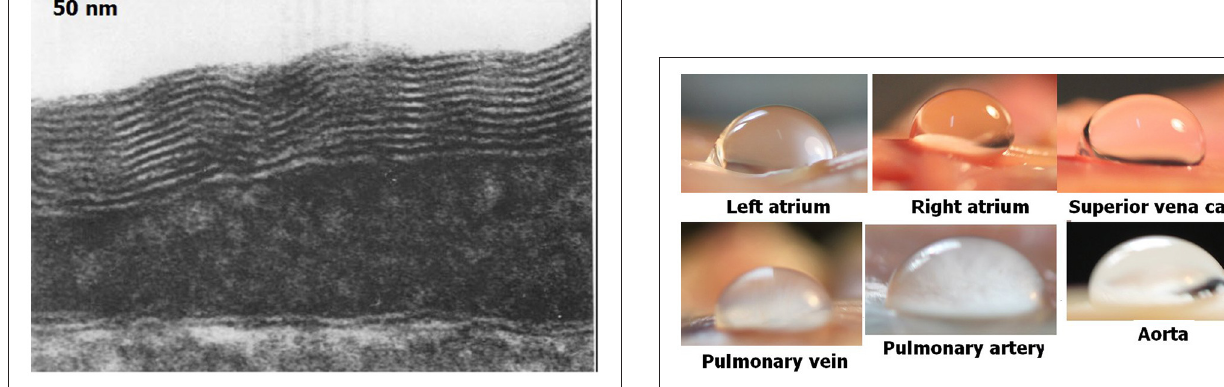
FIGURE 4 | Hydrophobicity on blood vessels. Hydrophobicity was demonstrated at specific locations using a small drop of saline and a large contact angle (taken from Arieli and Marmur, 2013b with